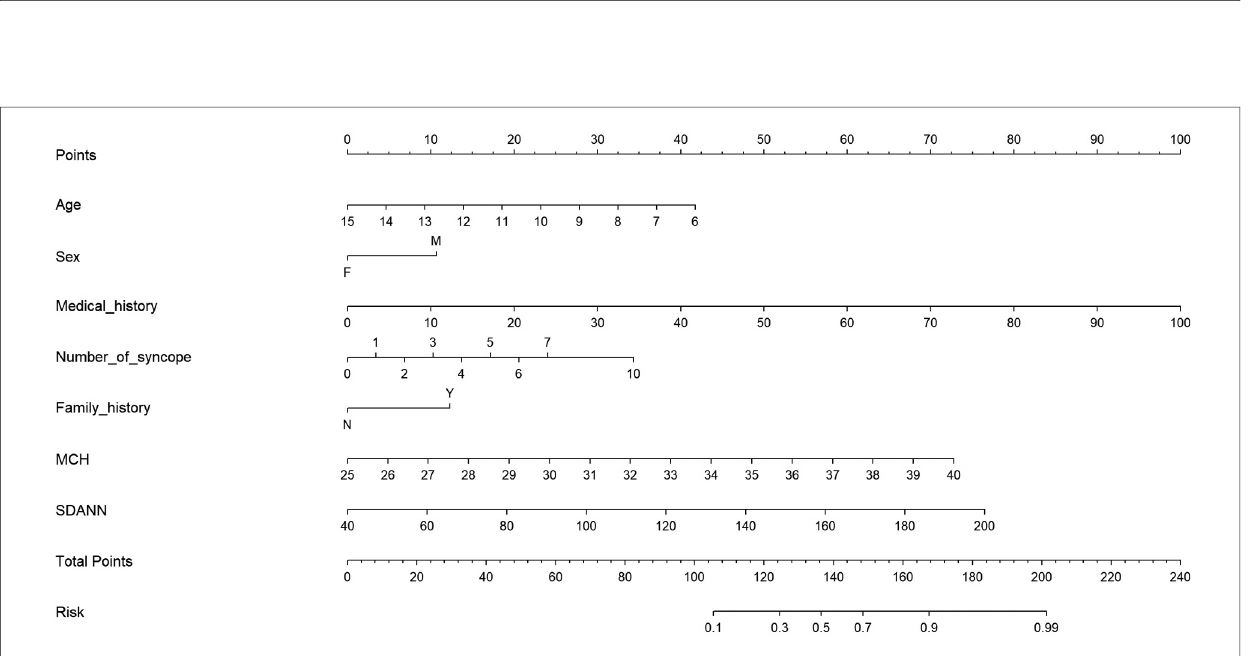
FIGURE 3 Prediction nomogram of convenient and signi fi cant factors for malignant VVS. Abbreviations: Medical history, the medical history of VVS (counts in months); F, female; M, male; MCH, mean corpuscular hemoglobin; SDANN, standard deviation of the average RR intervals in